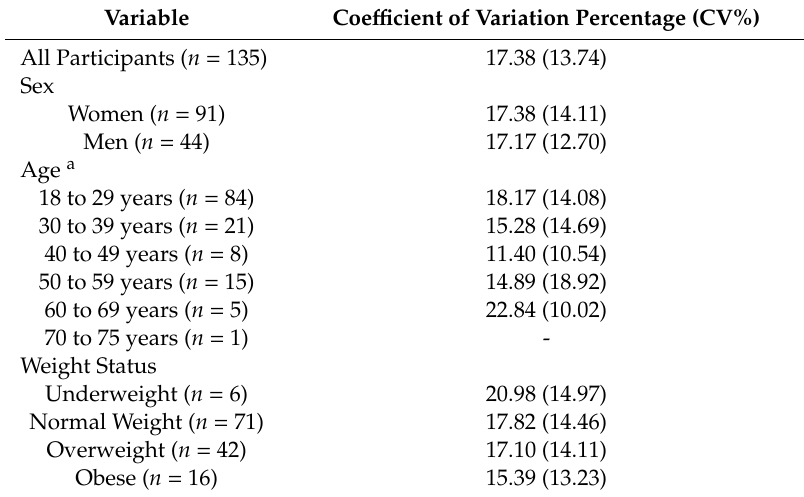
Table 6. Coe ffi cient of variation between the magnesium food frequency questionnaire and 14-day food diary by sex, age, and body mass